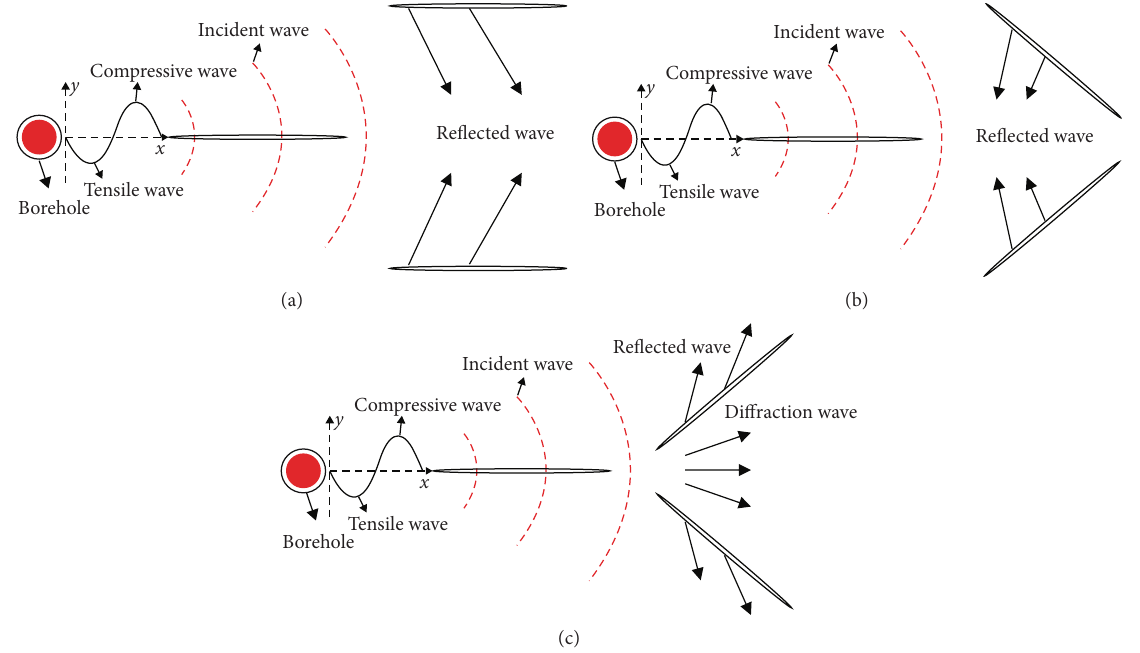
Figure 18: The diagram of P -wave propagation. (a) Parallel cracks. (b) Included angle toward inside. (c) Included angle toward